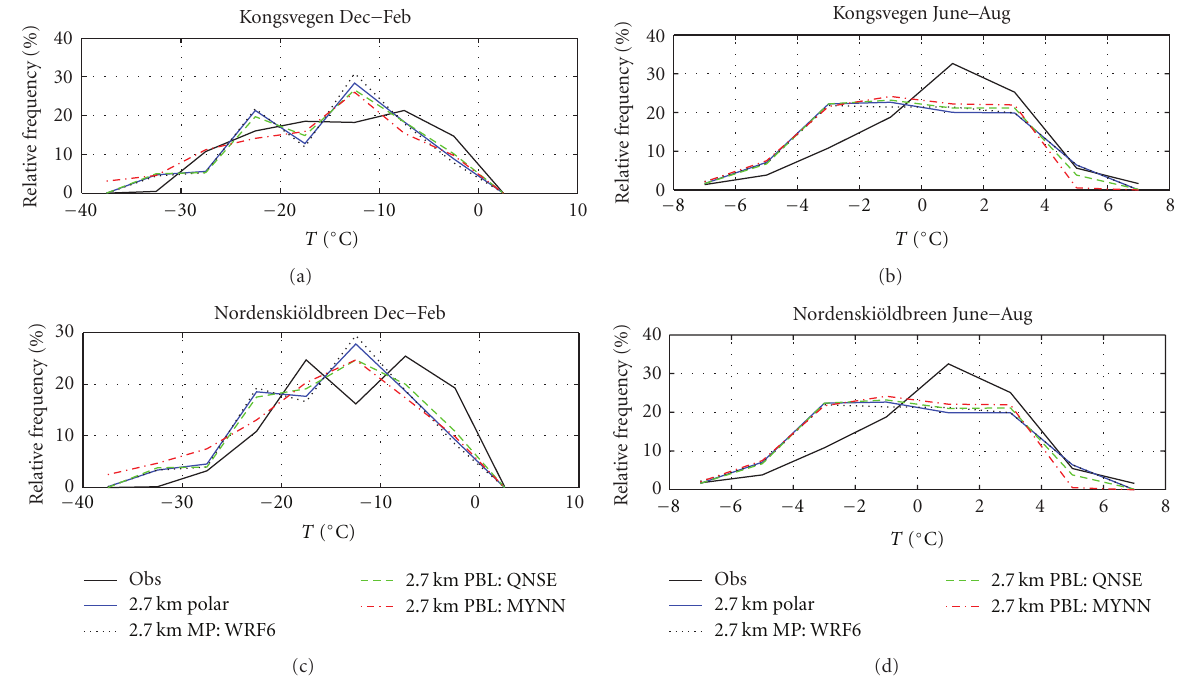
Figure 7: Frequency distribution of temperature in Kongsvegen and Nordenski¨oldbreen.